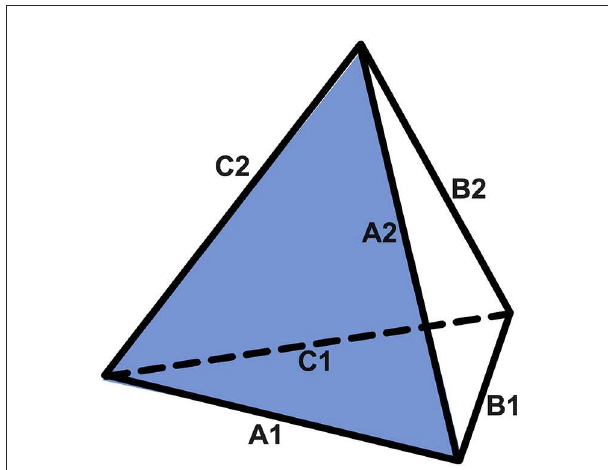
FIGURE2 A regular tetrahedron as a geometric representation of the symmetry across domains of rPD, dyadic process, and Mahayana Buddhism. There are six sides of equal length in a regular tetrahedron, with three sides that form the bottom (A1, B1, and C1)—representing the theoretical aspects of rPD, dyadic processes, and Mahayana Buddhism, respectively—and three sides that point toward the apex of the regular tetrahedron (A2, B2, and C2)—representing the practical aspects of rPD, dyadic processes, and Mahayana Buddhism, respectively. The symmetry in the theoretical aspects is represented by the basal regular triangle that is formed by A1, B1, and C1: A1 refers to interactive payoff matrices and associated mathematical requirements in rPD; B1 refers to dyadic processes modeled as two strongly coupled active inference engines; and C1 refers to the wisdom that directly realizes the ultimate nature of reality according to Mahayana Buddhism. Likewise, the symmetry in the practical aspects is represented by those apex-oriented sides, A2, B2, and C2: A2 refers to the best winning TTF-like strategies in rPD; B2 refers to the methods to maintain a conflict-proof intersubjectivity in strongly coupled dyads; and C2 refers to a path that inseparably combines compassion and wisdom. The unity of the regular tetrahedron is made possible because all three domains are fundamentally based on the same ultimate nature of reality, i.e., effects are the interactive products of causes by